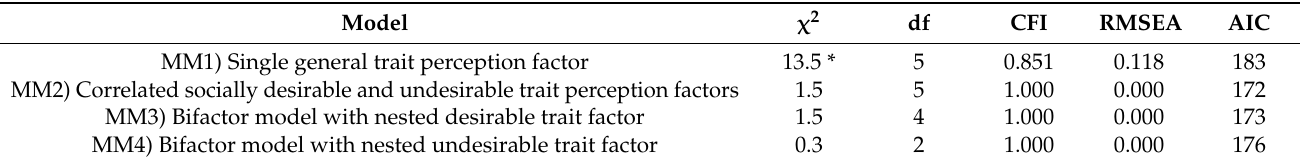
Table 6. Study 2: Model fit of the trait perception ability measurement models.